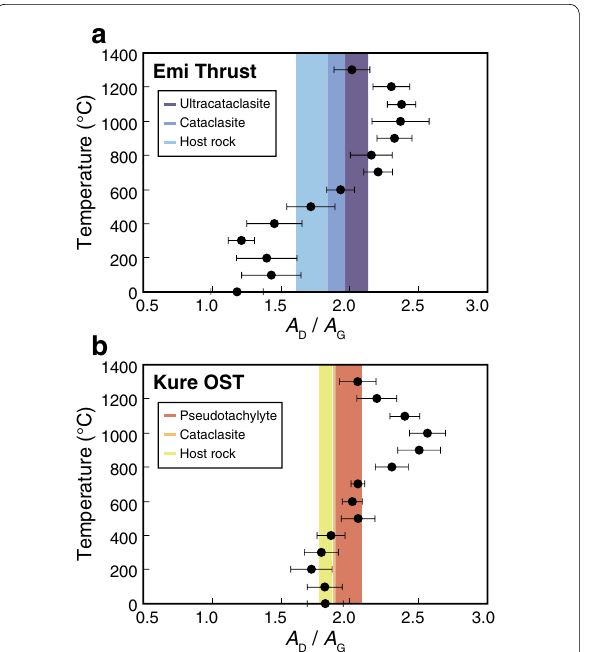
Fig. 6 Temperature dependencies of A D /A G ratios of Raman spectra of heated CM from host-rock samples and of CM from discrete slip zones. a Emi major thrust; b Kure OST